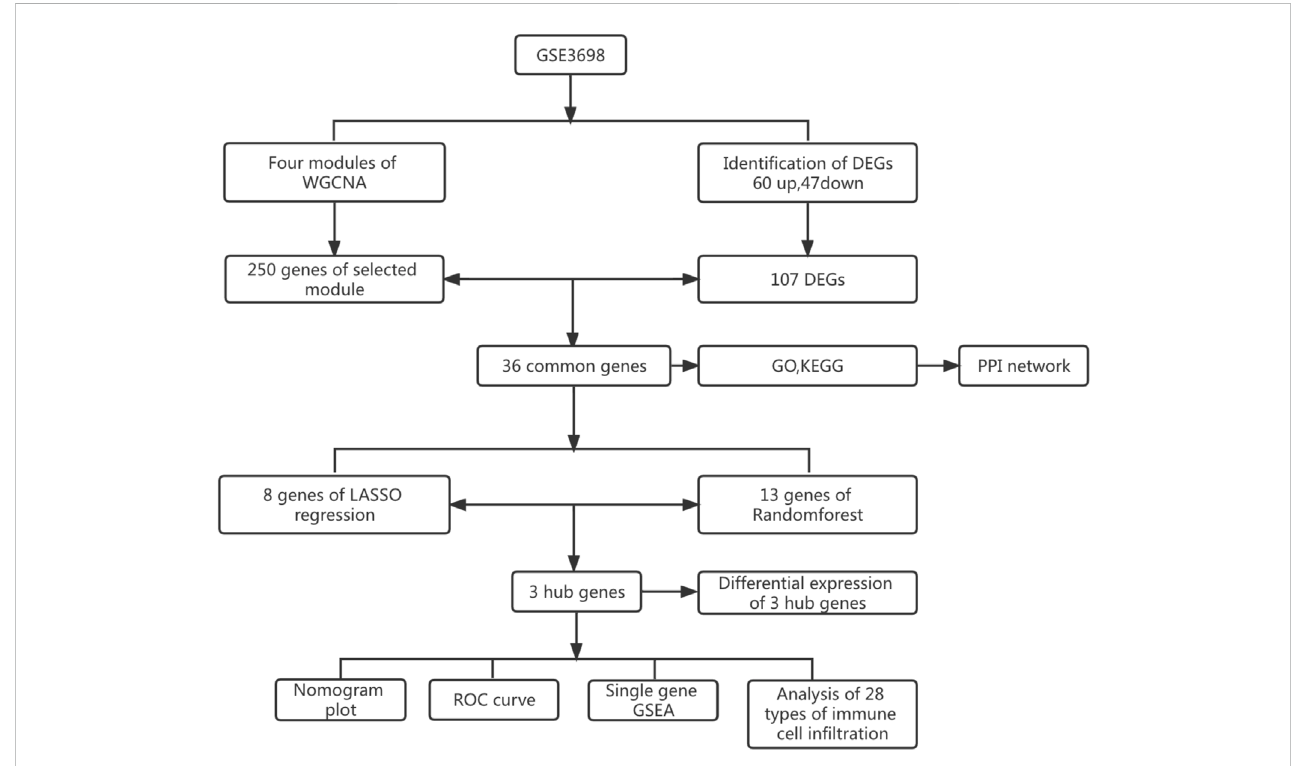
FIGURE 1 Research process fl ow diagram.